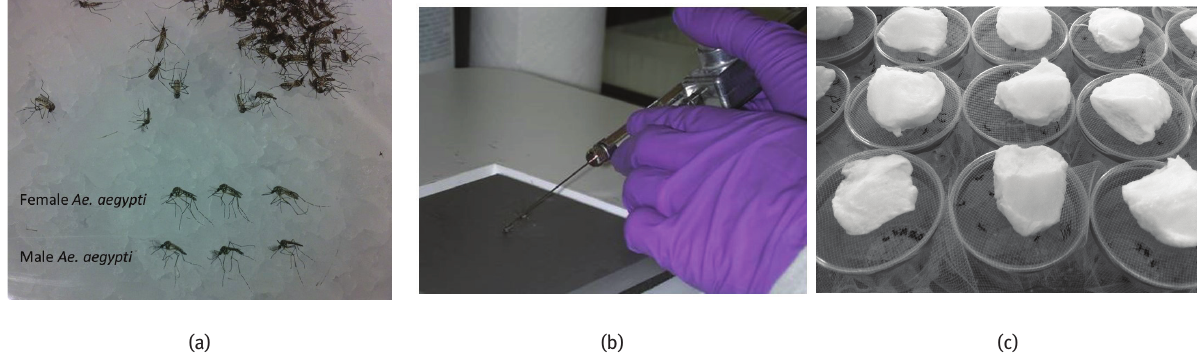
Figure 3: Adult bioassay against female Ae. aegypti , a) selecting female mosquitoes; b) compounds were topically applied to individual mosquitoes; c) After treatments, mosquitoes were kept in plastic cups with 10% sucrose solution for 24 h before mortality was